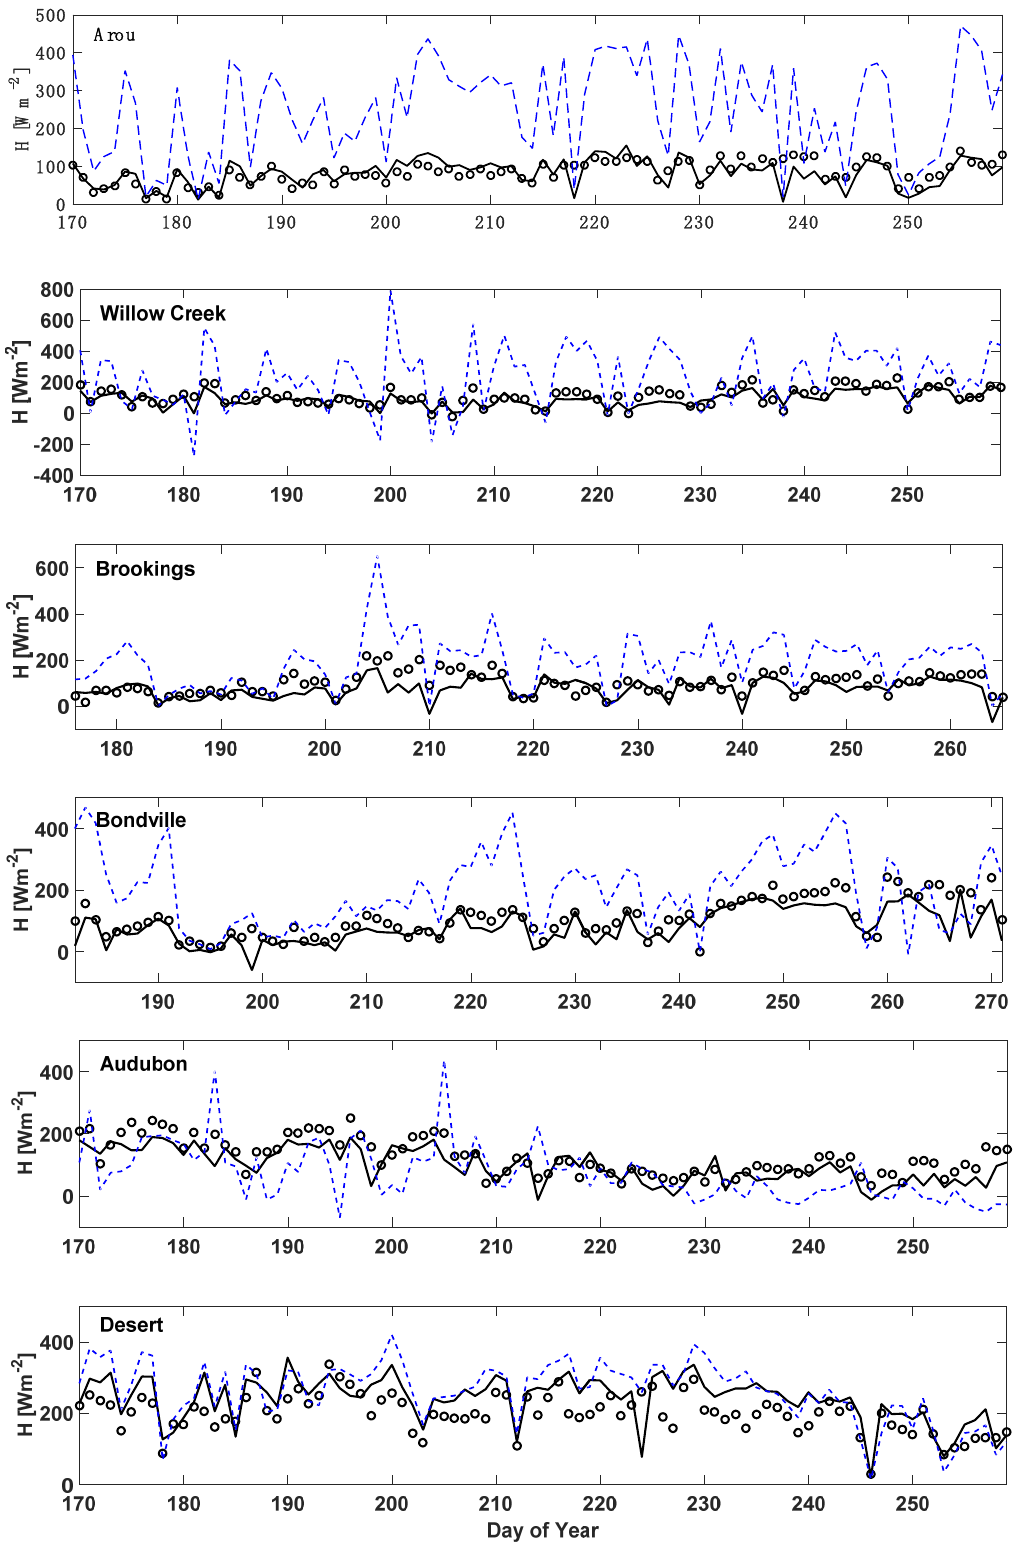
Figure 7. Time series of sensible heat flux ( H ) estimates from the VDA (solid lines) and open loop (blue dashed lines) approaches at the six study sites. Observed H values are shown by open circles.